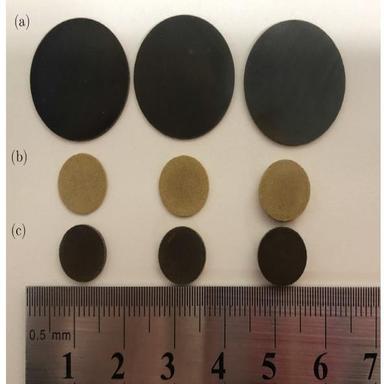
Photographs of samples made of: (a) material 1 (commercial samples), (b) material 2 (in-house prepared samples sintered at 1400◦C) and (c) material 3 (inhouse prepared samples sintered at 1500◦C).